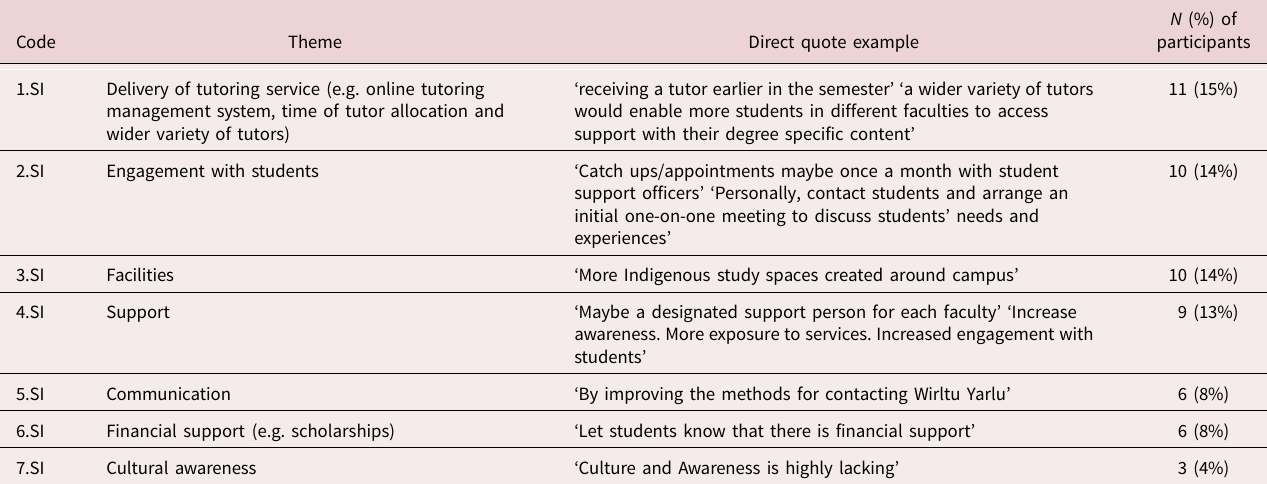
Table 4. Content analysis of support improvements for Wirltu Yarlu ( N